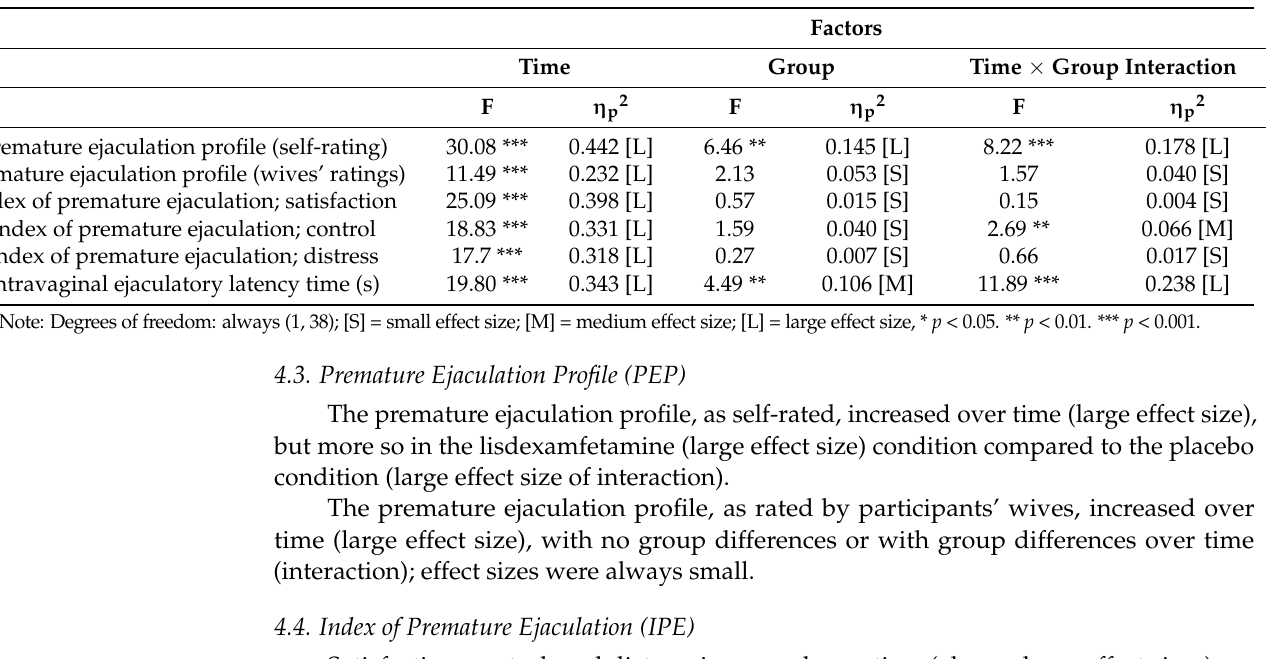
Table 3. Inferential statistical indices of dimensions of early ejaculation, at baseline and at the end of the study 4 weeks later, separately for participants in the lisdexamfetamine and the placebo